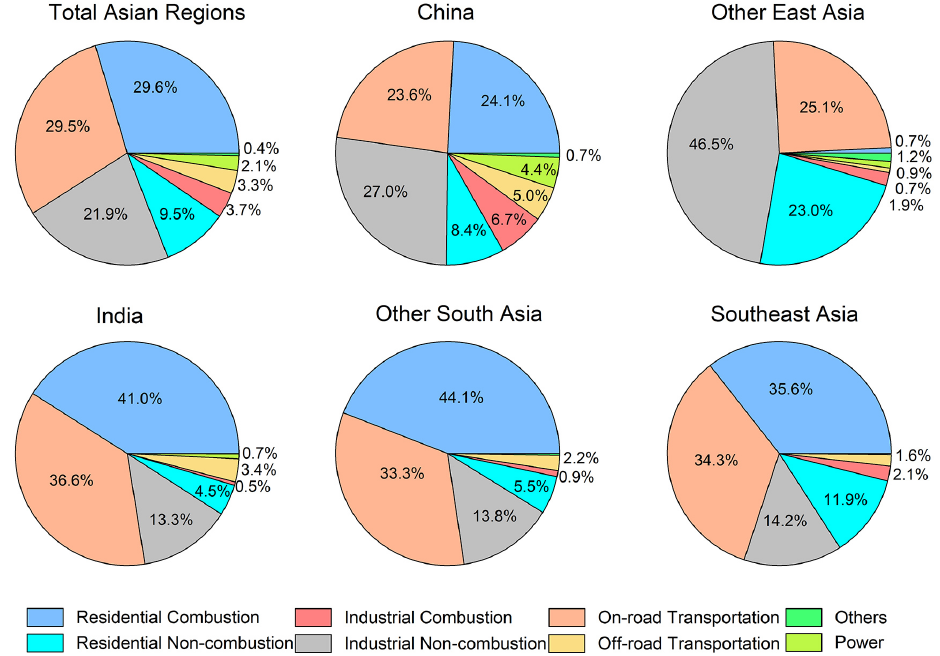
Figure 2. The 2006 NMVOC emissions by Asian regions in the INTEX-B